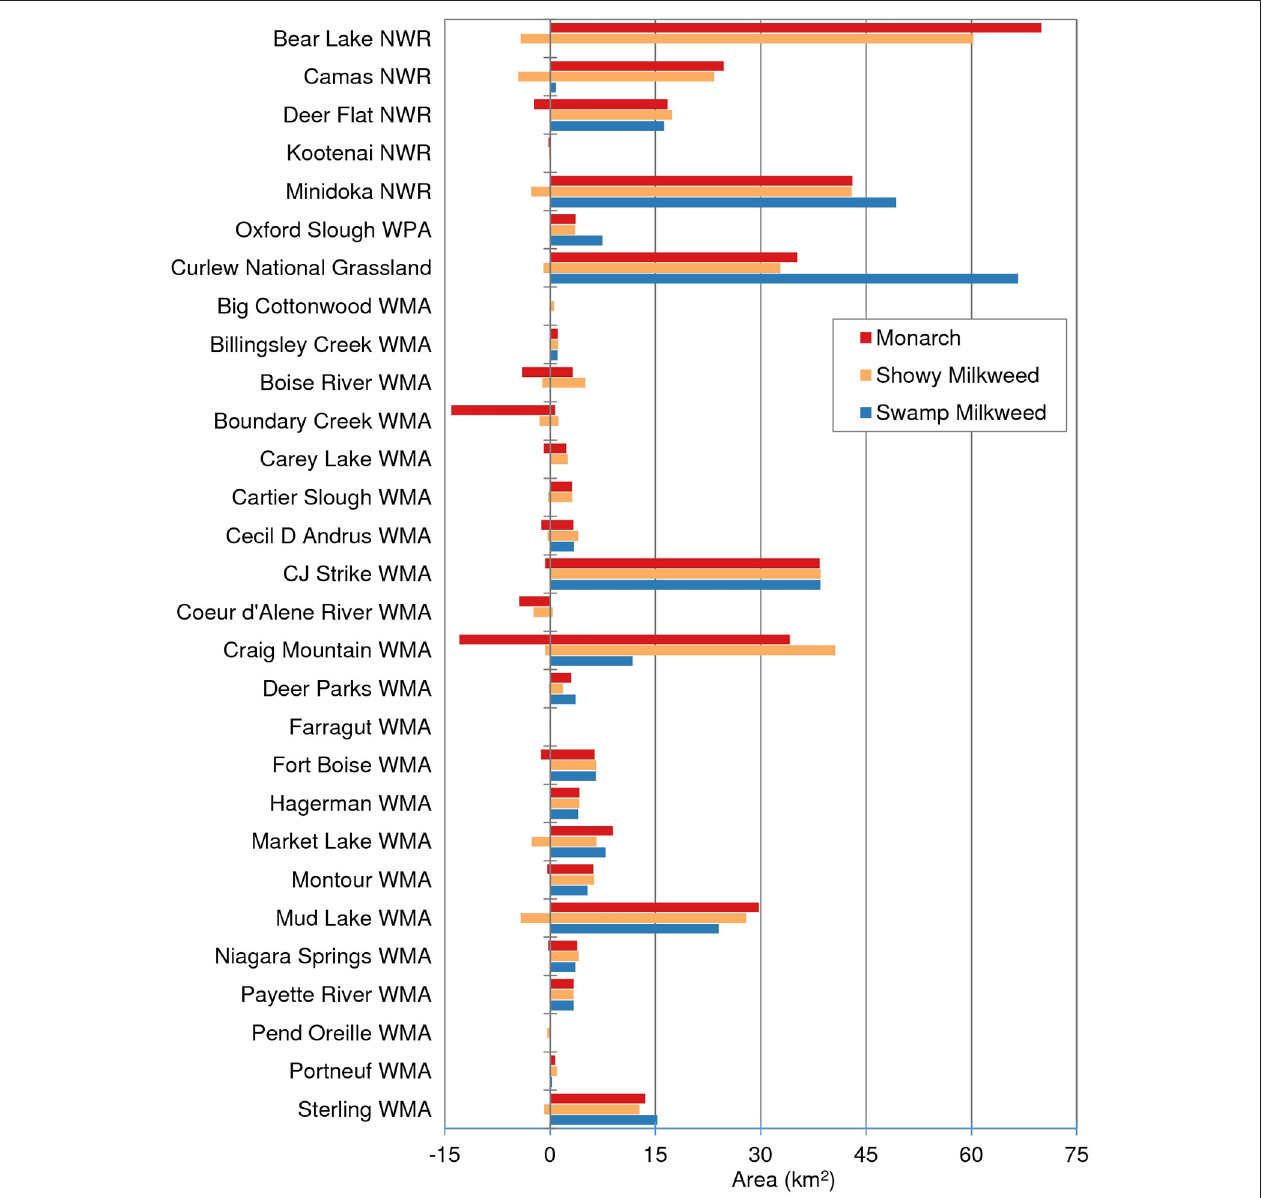
FIGURE 6 | Area (km 2 ) of projected suitable habitat for showy milkweed, swamp milkweed, or monarch breeding by mid-century under a severe (RCP8.5) climate change scenario within selected managed areas in Idaho. Positive values represent persisting and/or expanding habitat while negative values indicate habitat